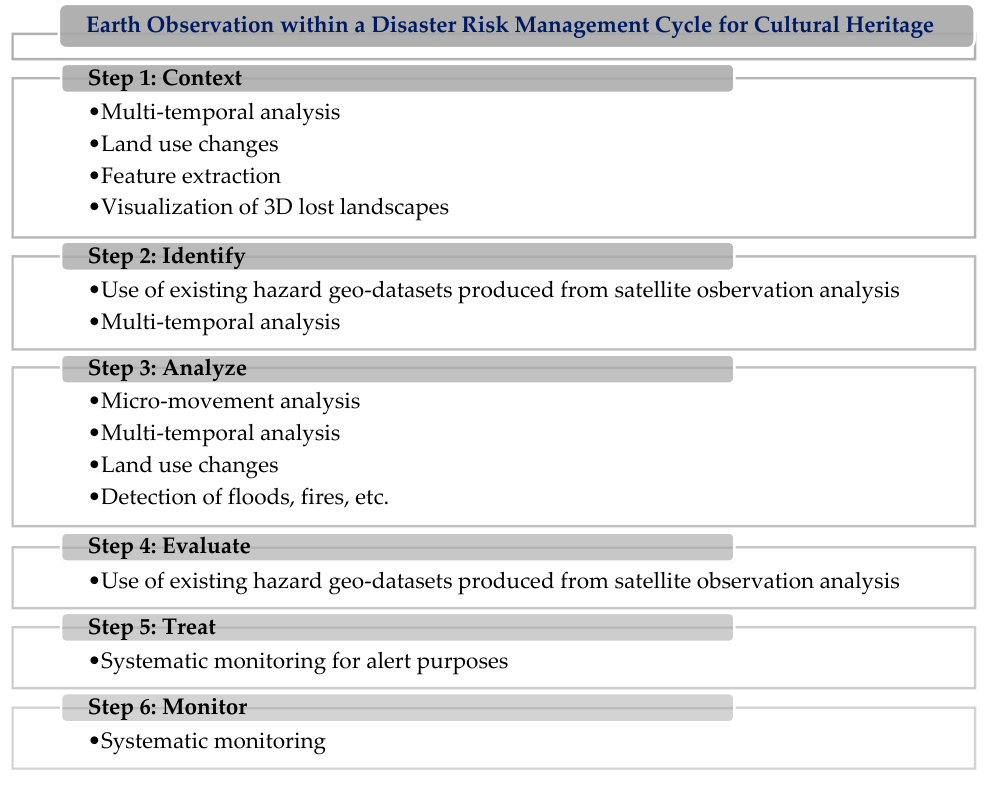
Figure 6. Indicative key satellite observation processing chains beneficial for the various steps of a DRM cycle intended for cultural heritage.